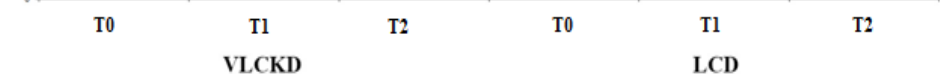
Figure 1. VLCKD and LCD diets induce a reduction in BMI values with statistical significance ( p < 0.01).